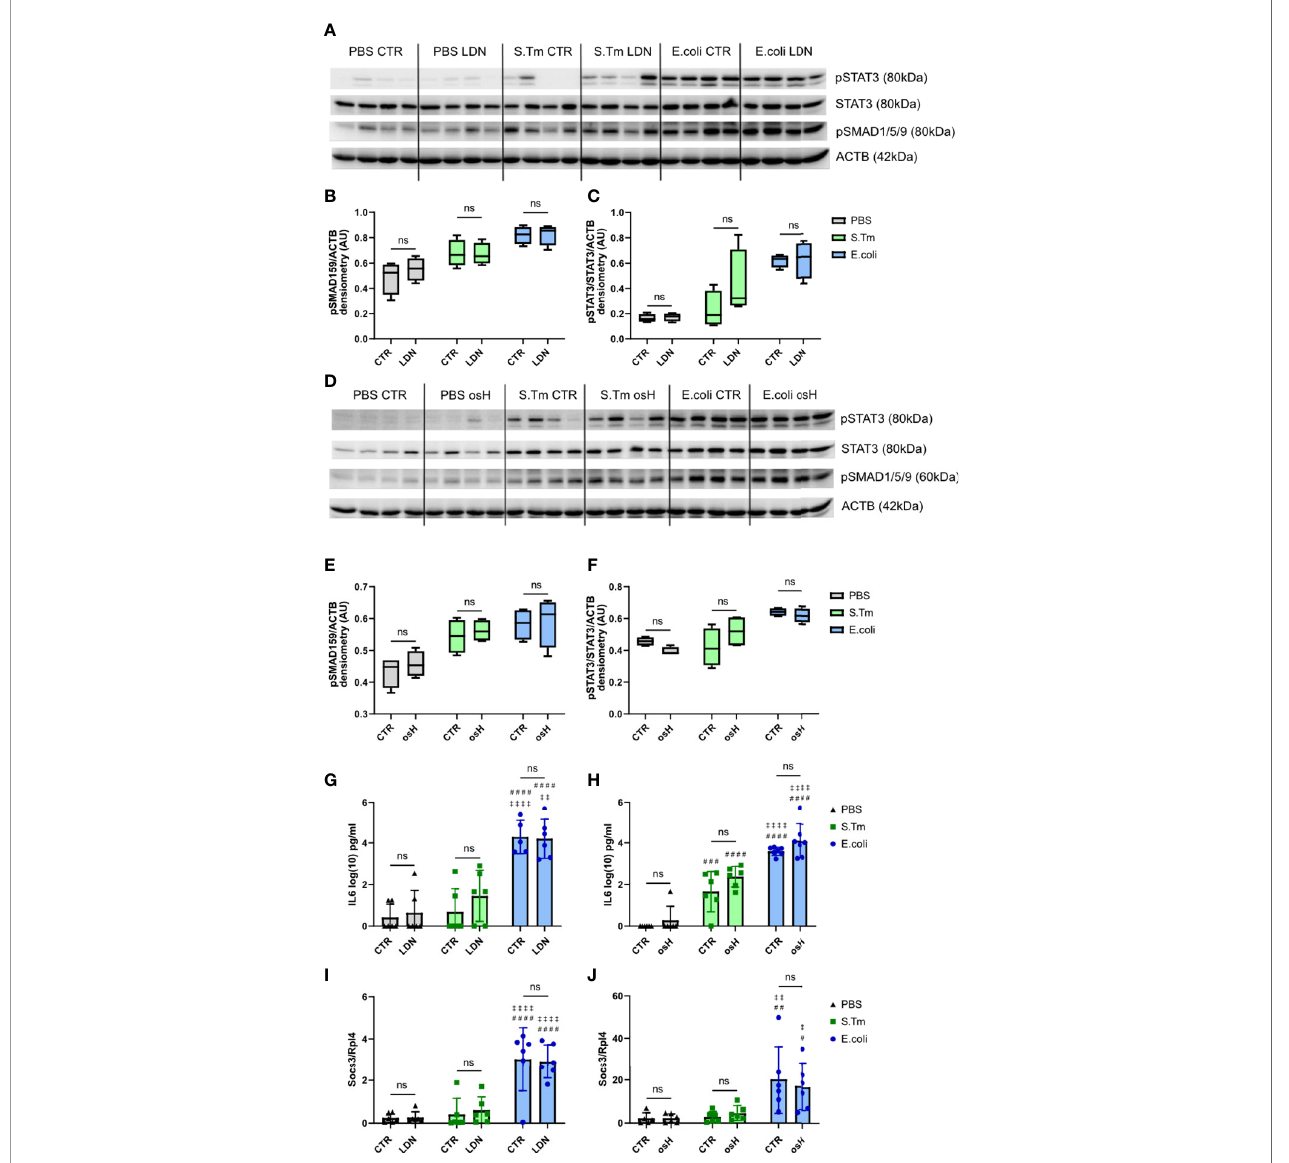
FIGURE 3 | Hepcidin regulation. (A, D) Western blots of liver protein extracts of phosphorylated signal transducer and activator of transcription – 3 (pSTAT3), STAT3, phosphorylated SMA and mothers against decapentaplegic-1/5/9 (pSMAD1/5/9) and actin (ACTB) of infected mice receiving the different hepcidin inhibitors are shown. (B, C, E, F) Quanti fi cation of the Western blot results. (G, H) Interleukin-6 (IL6) plasma levels in log(10) pg/ml measured using an ELISA kit. (I, J) Realtime PCR results of hepatic gene expression of suppressor of cytokine signaling-3 ( Socs3) with Ribosomal Protein L4 ( Rpl4) as a reference receiving either LDN-193189 (LDN), oversulfated heparins (osH) or the respective vehicle (CTR). For (A, D) , 4 representative samples of each group were chosen. (G – J) each dot indicates a single mouse. (G – J) n = 5-7 per group. A two-way ANOVA was performed for the results with more than 2 groups. ns: no signi fi cance of differences ; # signi fi cantly different from uninfected mice, ## p < 0.01, ### p < 0.001, #### p < 0.0001; ‡ signi fi cantly different from S.Tm infected mice, ‡ p < 0.05, ‡‡ p < 0.01, ‡‡‡‡ p <